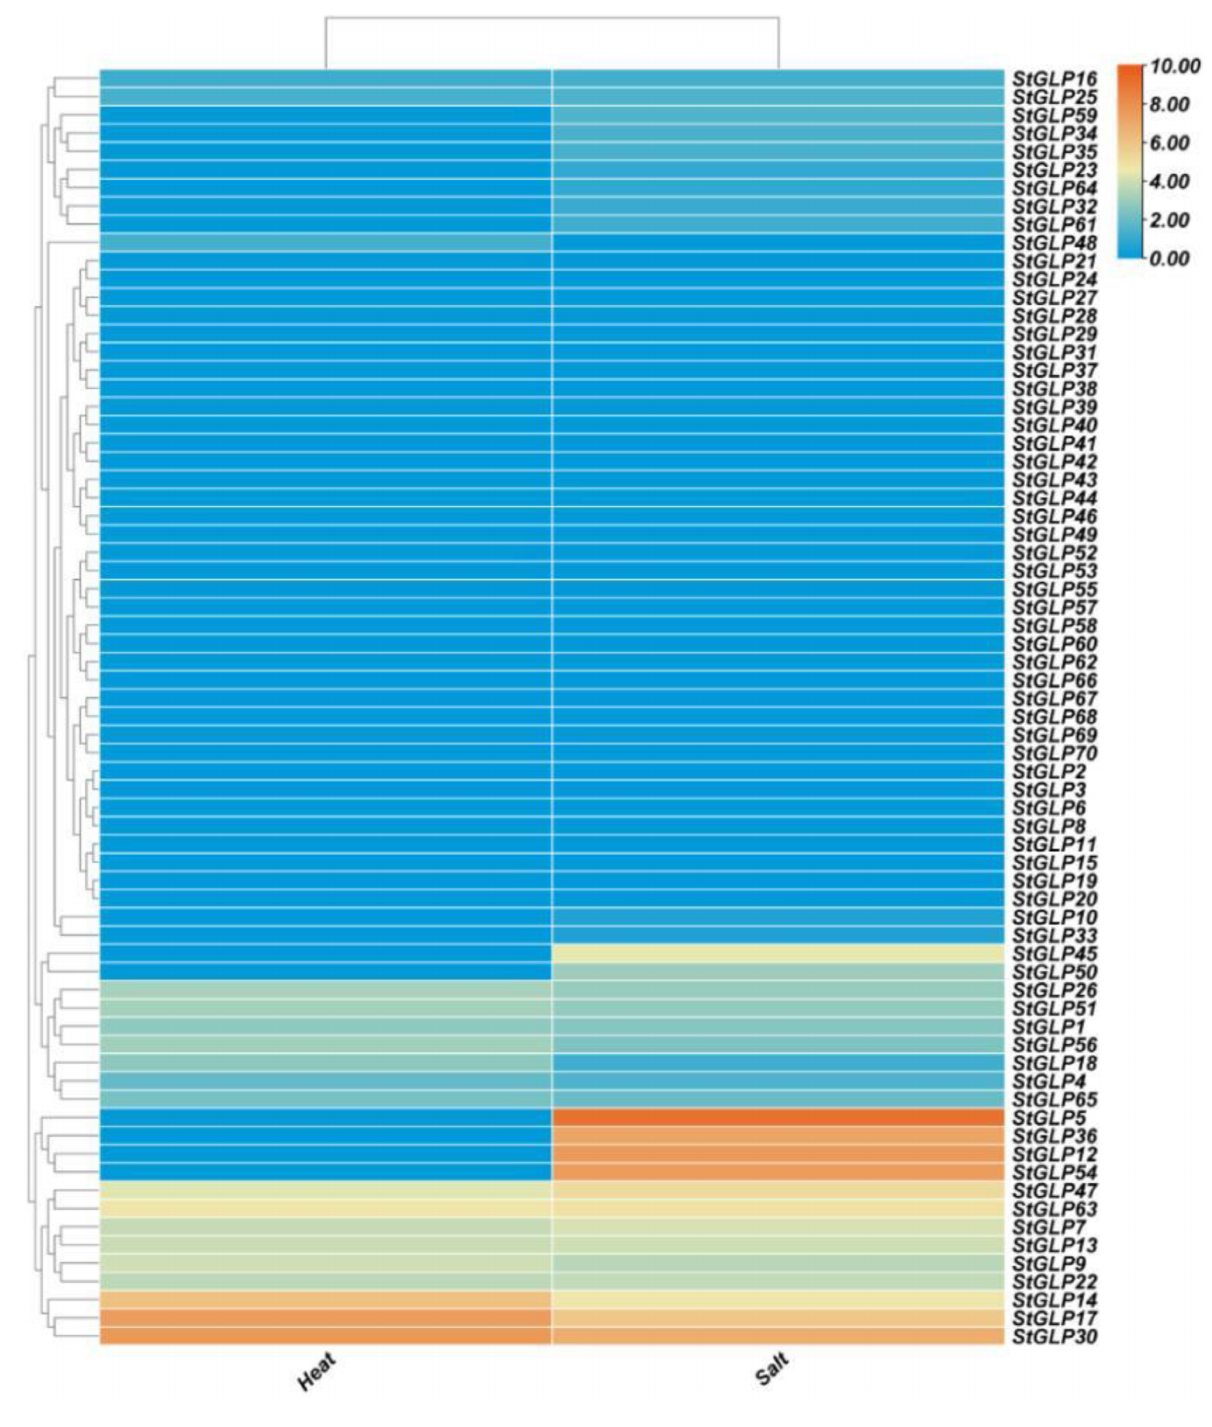
FIGURE 9 | Expression profiling of StGLP genes in response to salt and heat treatments. The orange and blue colors display high- to low-expression levels. The expression heat map was created by taking log10 of fragments per kilobase million